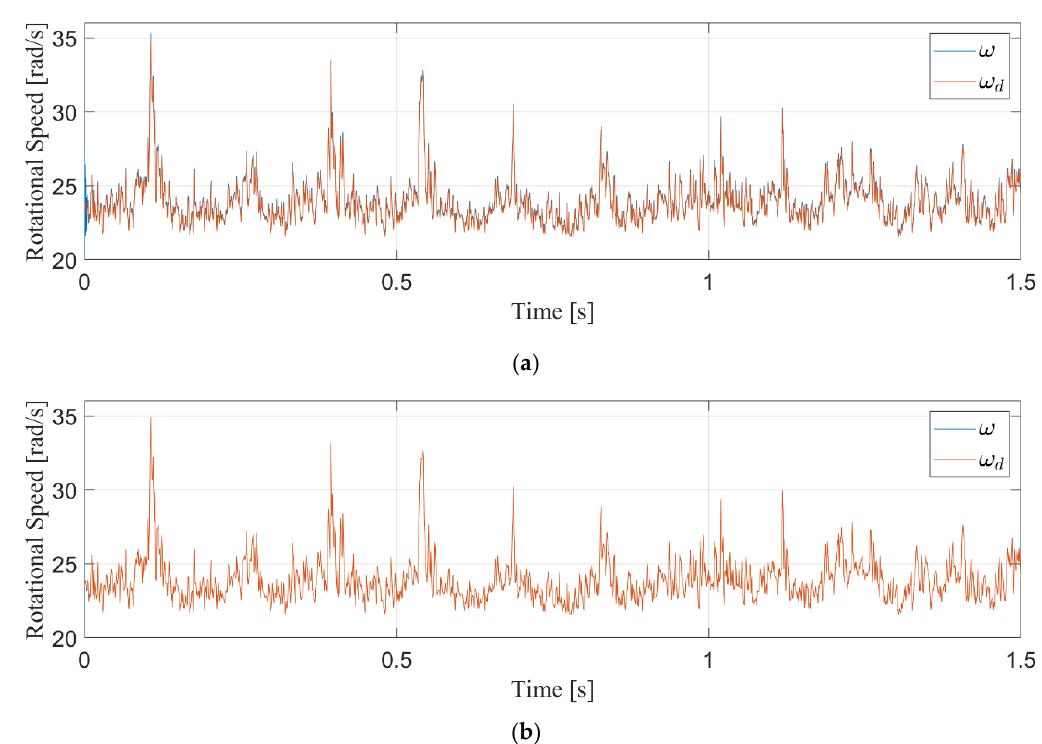
Figure 6. Rotational speed versus desired trajectory for linear controller ( a ) and nonlinear controller ( b ).